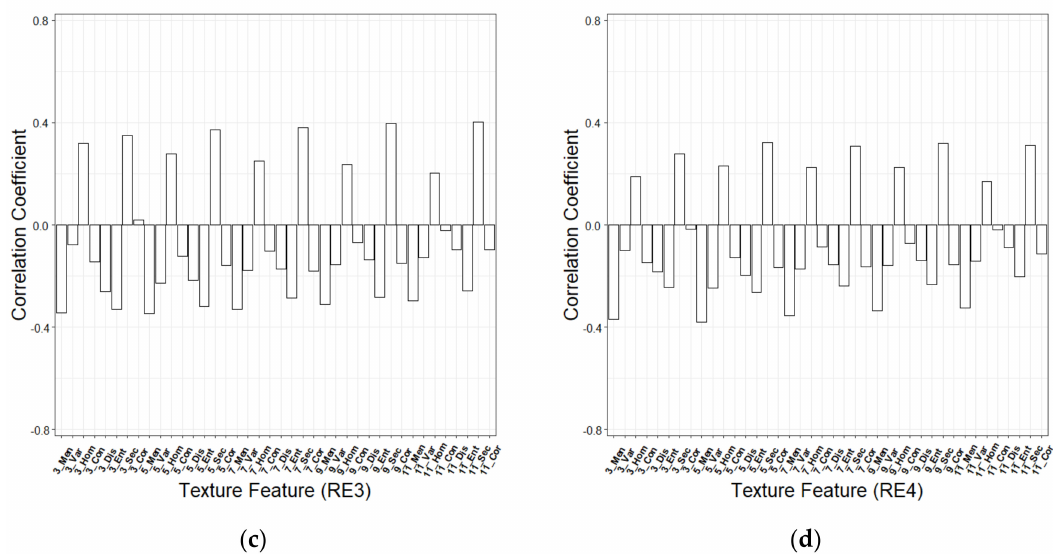
Figure 7. Correlation coe ffi cients of texture features extracted from ( a ) RE1, ( b ) RE2, ( c ) RE3 and ( d ) RE4.